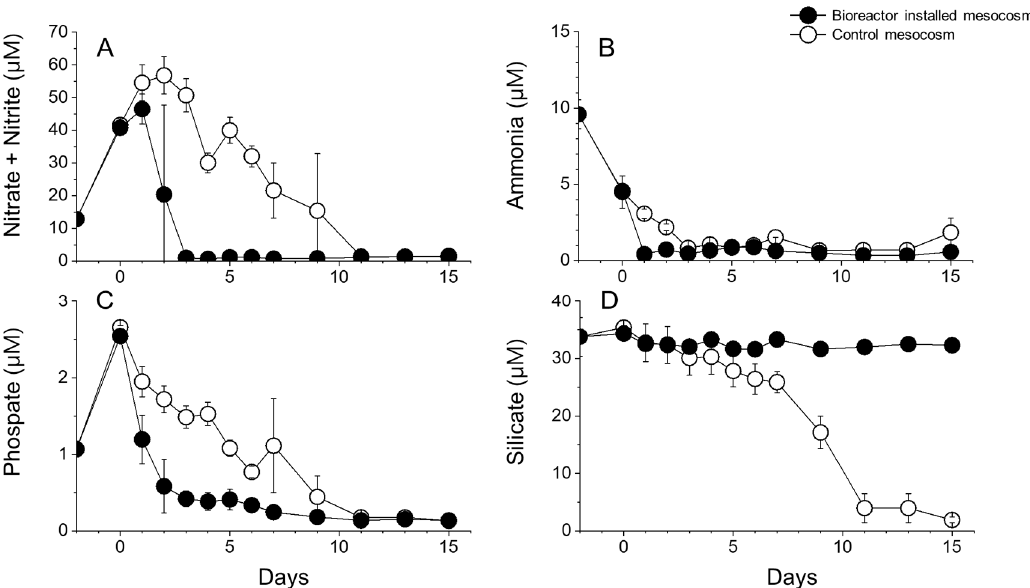
Figure 11. Changes in inorganic nutrient concentrations: nitrate + nitrite ( A ), ammonium ( B ), phosphate ( C ), and silicate ( D ) during mesocosm experiment period (15 days). Each value of white and dark circles was averaged by two measured values of bioreactor installed mesocosms or control mesocosms, respectively.